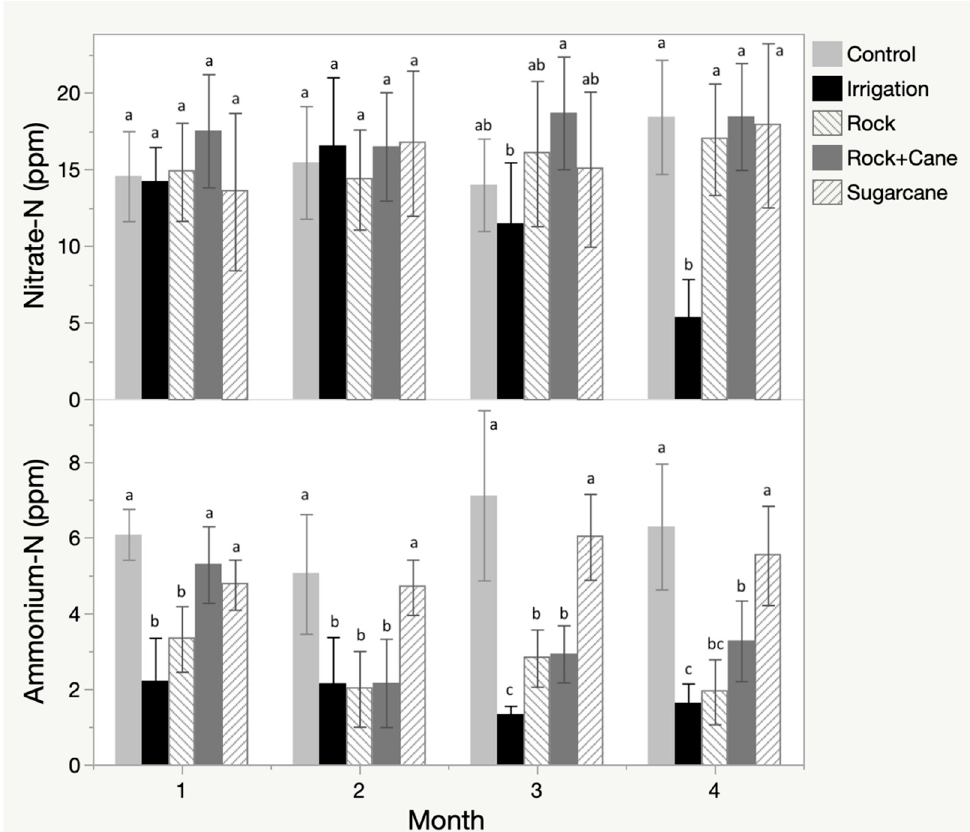
Figure 4. Nitrate and ammonium accumulation in the field experiment as measured by monthly soil samples, with letters representing significance using a Tukey HSD test.